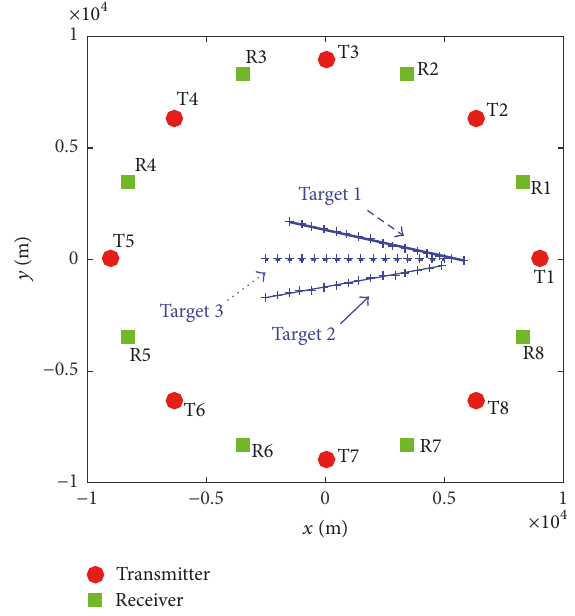
Figure 1: MIMO radar layout with moving targets. Table 2: High MSE thresholds for multiple targets